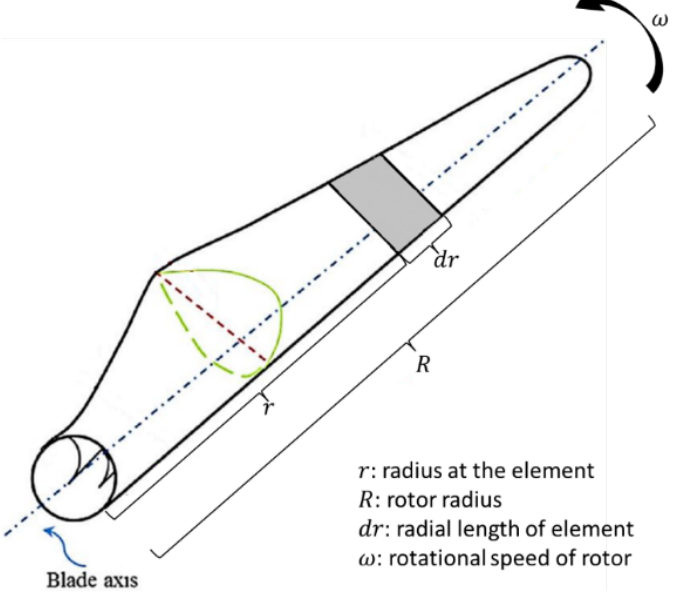
Figure 2. Diagram of blade elements.